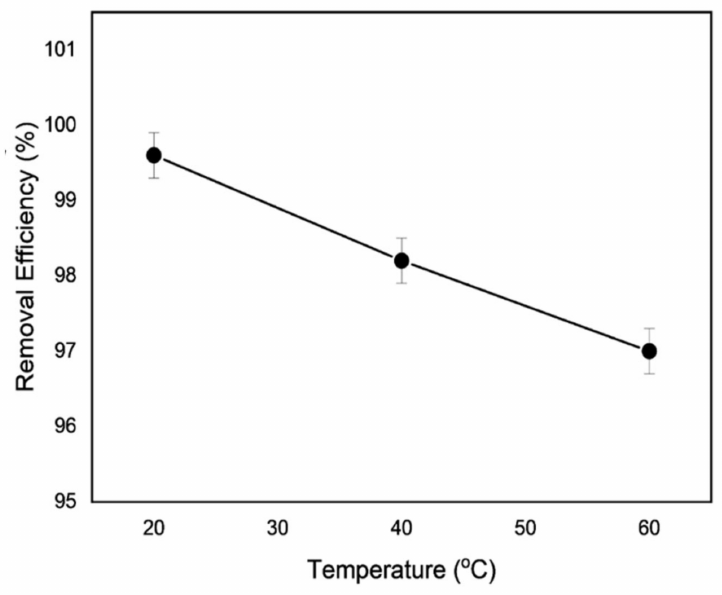
Figure 12. Shows how the adsorption of MB is impacted by